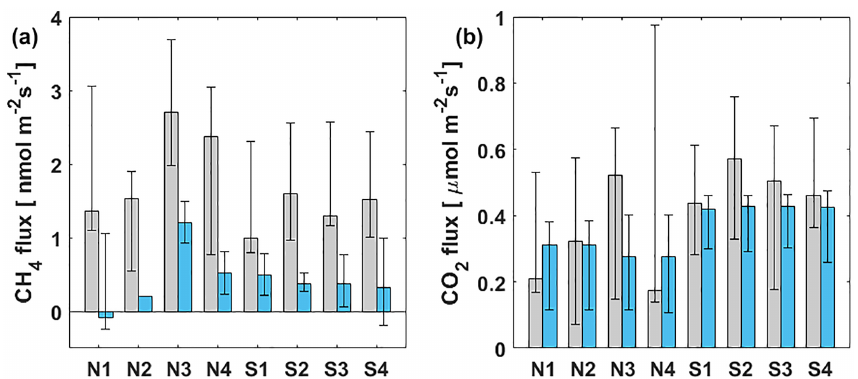
Figure 5. Median (a) CH 4 and (b) CO 2 FC fluxes (grey bars) at different measurement spots and median of simultaneous EC measurements (blue bars) during lake stratification. Black whiskers represent the 25th and 75th